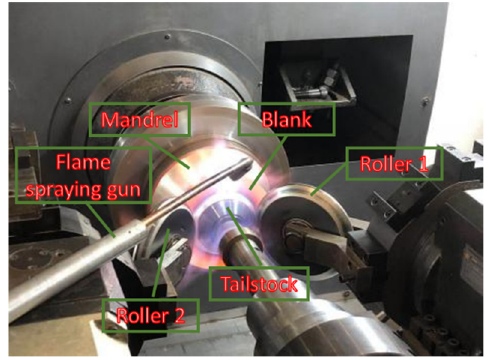
Figure 11. Spinning process.